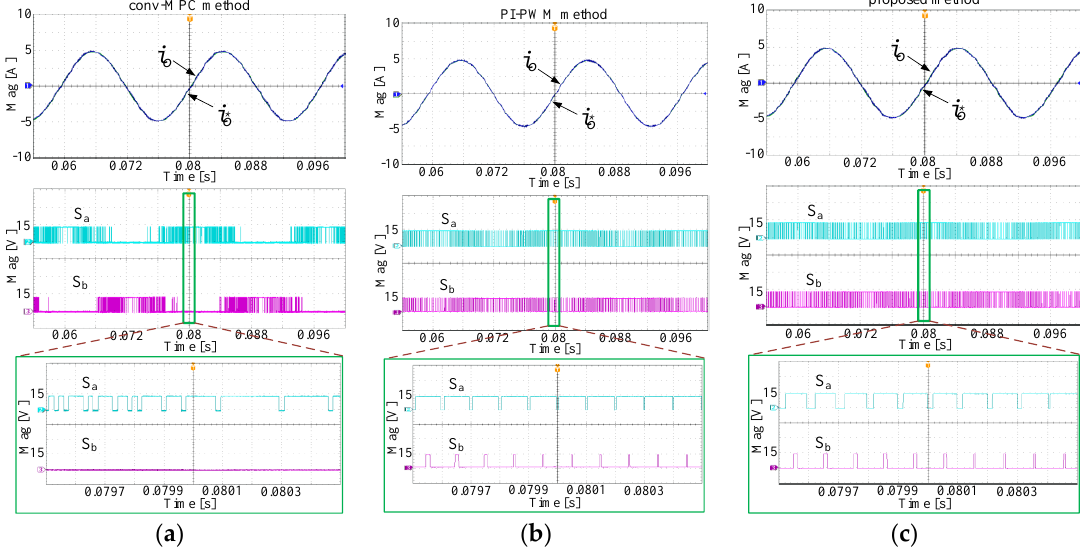
Figure 13. Experimental results of the output current ( i o ), the reference current ( i o* ) and upper switch states ( S a , S b ) obtained by ( a ) conv-MPC method ( T s = 33 μs); ( b ) PI-PWM method ( T sw = 200 μs); and ( c ) proposed method ( T s = 200 μs).